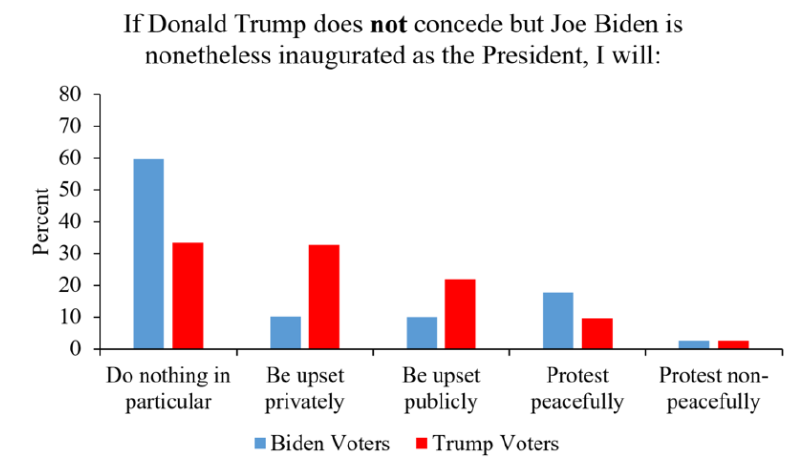
Figure 4. Forecasted behavior following the inauguration. Percent of Biden (blue) and Trump (red) voters forecasting different reactions to the hypothetical of Biden becoming President despite a lack of concession from Trump. Note that the question wording was not exactly as stated in the figure